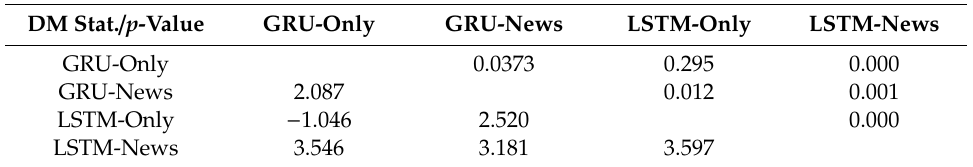
Table 6. Diebold–Mariano (DM) tests on Mean absolute error (MAE) between forecasting models for Nepal Stock Exchange